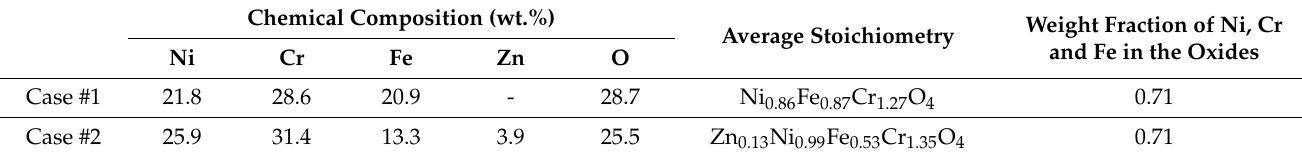
Table 4. Average chemical compositions of the